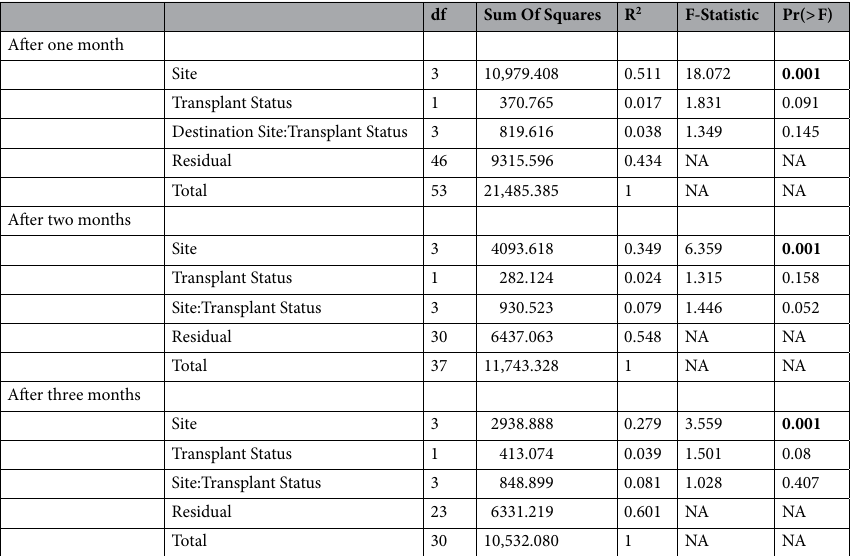
Table 2. Results of PERMANOVA showing differences among based on variation in transplant status in leaves (Fig. 3A-C). Significant values are in bold.